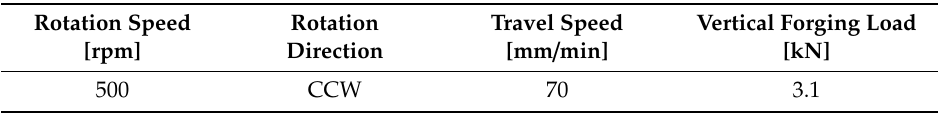
Table 1. Parameters of the FSC process implemented in the production of the channels for the samples. Parameters refer to schematics represented in Figure